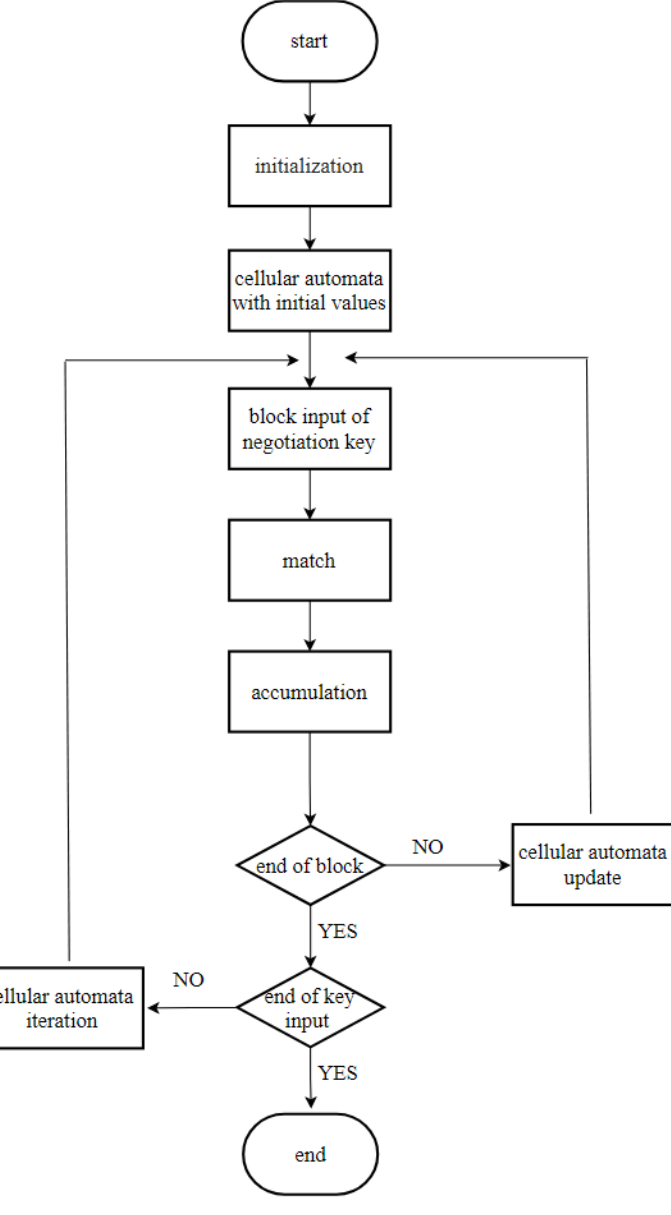
Figure 3. Flow chart of PA